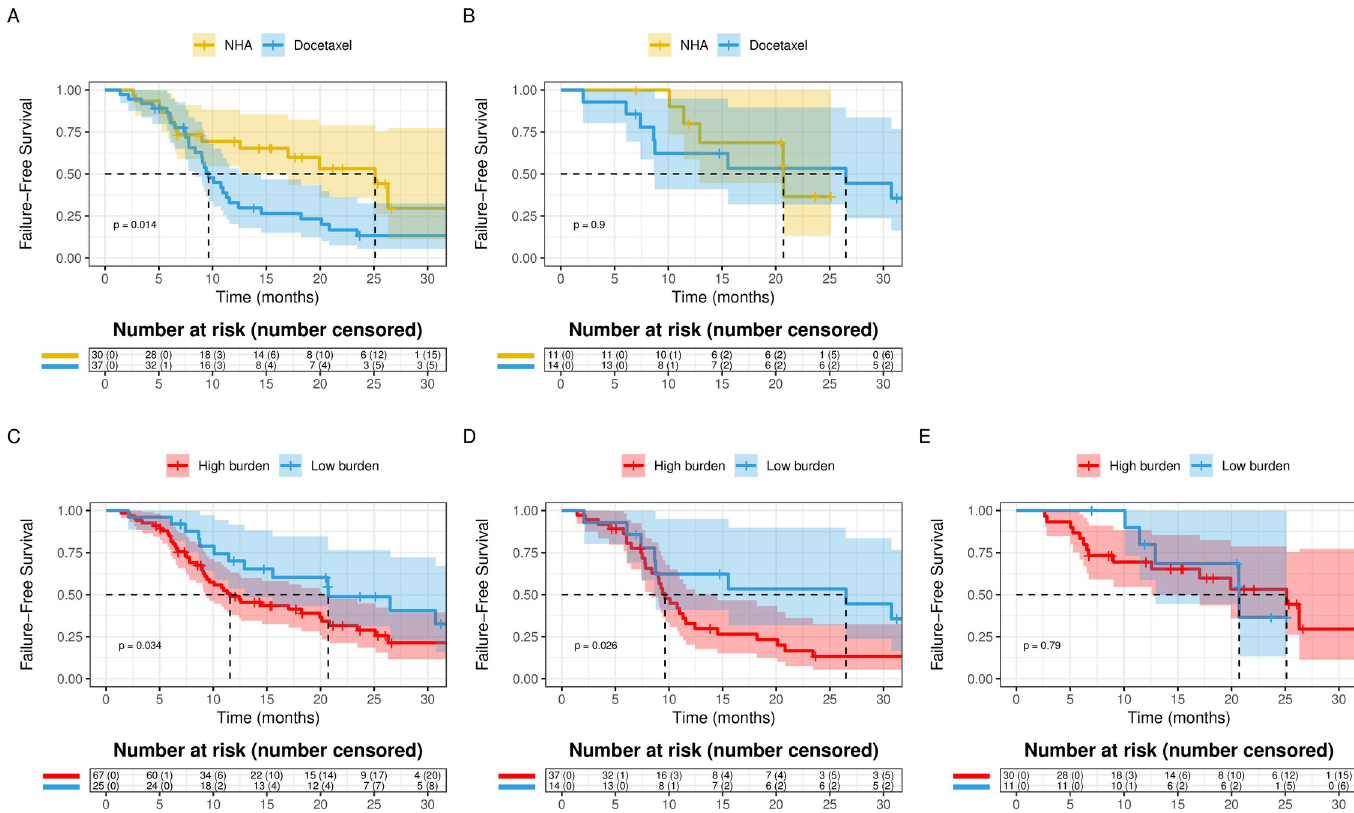
Fig 2. Kaplan-Meier analysis for TTNT comparing patients treated with upfront docetaxel versus upfront NHA in A. High metastasis B. Low metastasis burden patients. Kaplan-Meier analysis for time to next treatment (TTNT) comparing patients with high and low metastasis burden in C. all mHSPC patients, D. Patients treated with upfront docetaxel and E. Patients treated with upfront NHA.